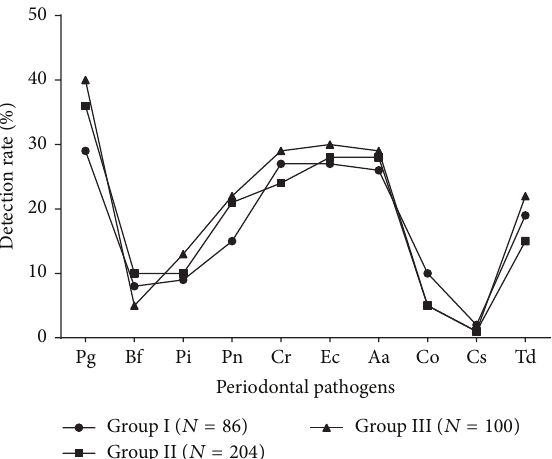
Figure 3: Detection rate of periodontal pathogens among various age